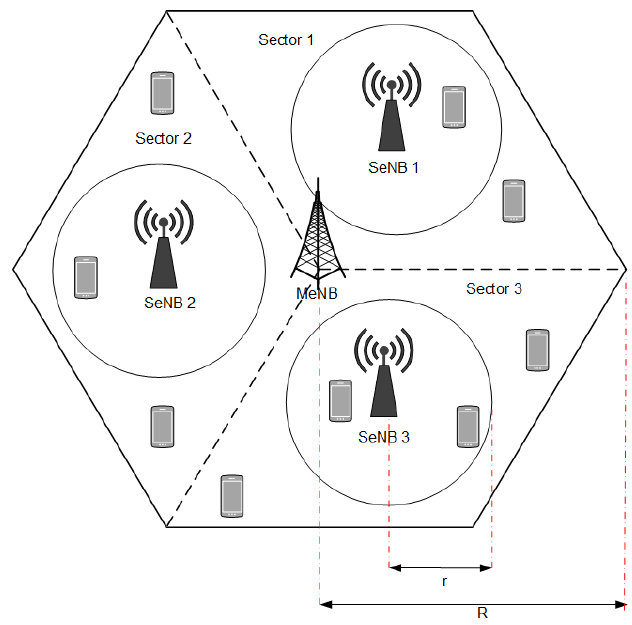
Figure 1. System model for